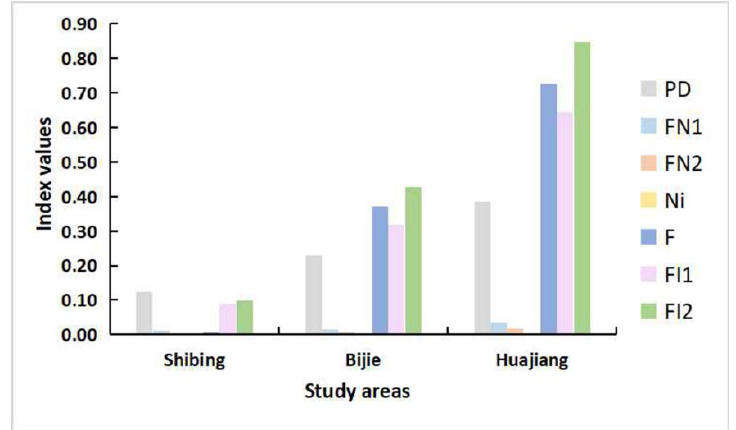
Figure 2. Habitat fragmentation index of Erythroneurine leafhoppers in three different study areas. ( PD : Patchdensity index; FN 1 and FN 2 : Landscape fragmentation index; Ni : Separateness index; F : Fragmentation index; FI 1 and FI 2 : Inside habitat area fragmentation index).